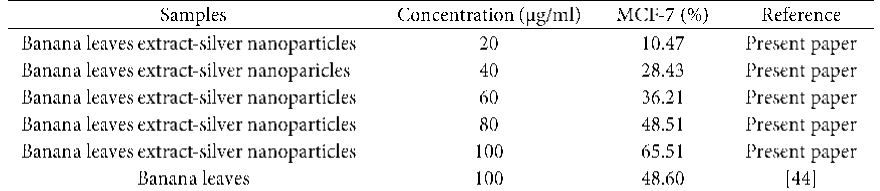
Fig. 11 Effect of the BL-AgNPs on the breast cancer A549 cell line: (a) untreated cell line, (b) 20 μg/ml, (c) 40 μg/ml, (d) 60 μg/ml, (e) 80 μg/ml, (f) 100 μg/ml of BL -AgNPs (treated cell line) and (h) standard drug (Cis platin) Table 3. Cytotoxic effects of Banana leaves extract- silver nanoparticles at five different concentrations and banana leaves extract at 100